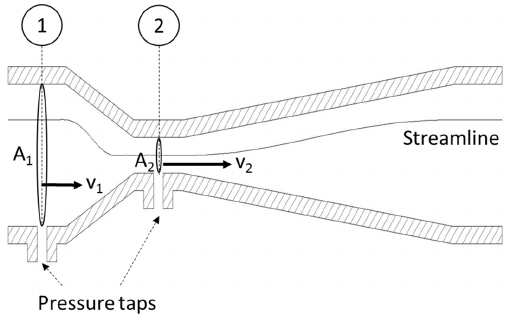
Figure 2. Venturi